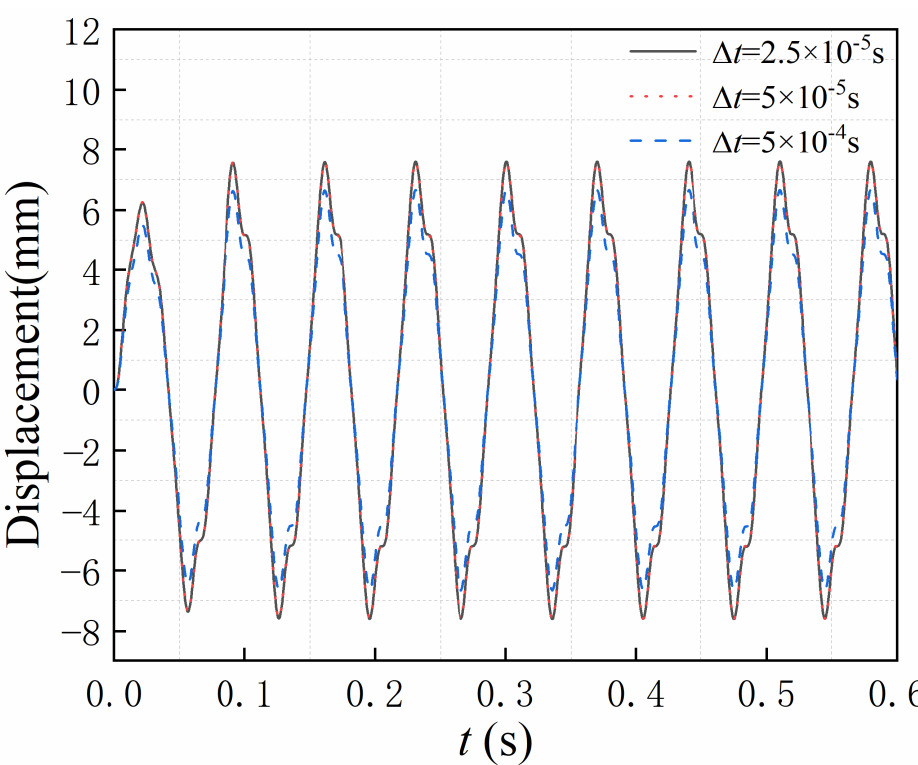
Figure 14. Dynamic responses of the bonded Timoshenko beam model under different time-step, F 0 = 300 N, ω = 90 rad/s.